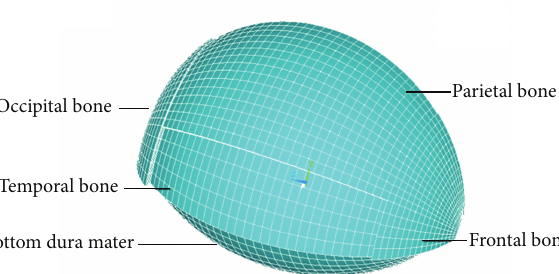
Figure 9: Skeleton of the cranial cavity trendline.